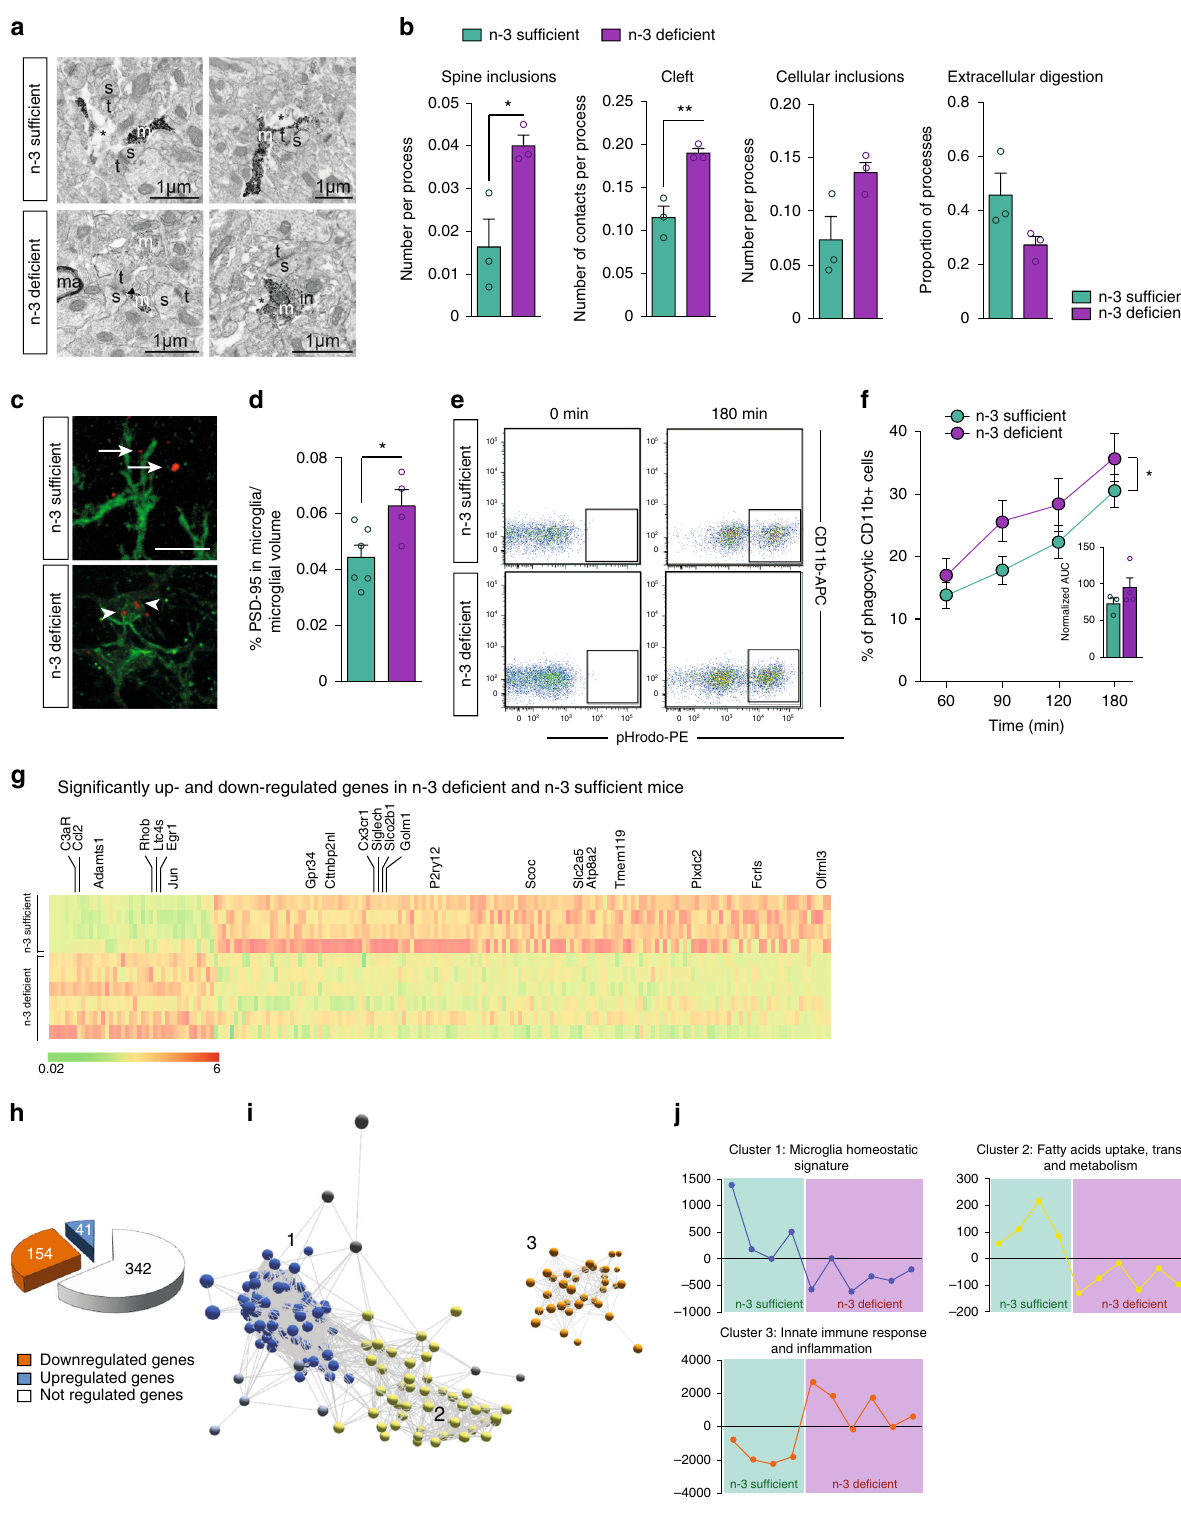
were signi fi cantly modi fi ed by the diet, such as the saturated fatty acid (SFA) stearic acid (18:0) and docosanoic acid (C22:0), and the monounsaturated fatty acids (MUFA) C16:1 n-7, C16:1 n-9, C18:1 n-9, and C20:1 n-9. Overall, our results show that n-3 and n-6 PUFA pro fi les of both microglia and synaptosomes are altered by low maternal n-3 PUFA intake, displaying similarities and discrepancies (Fig. 3a, b).